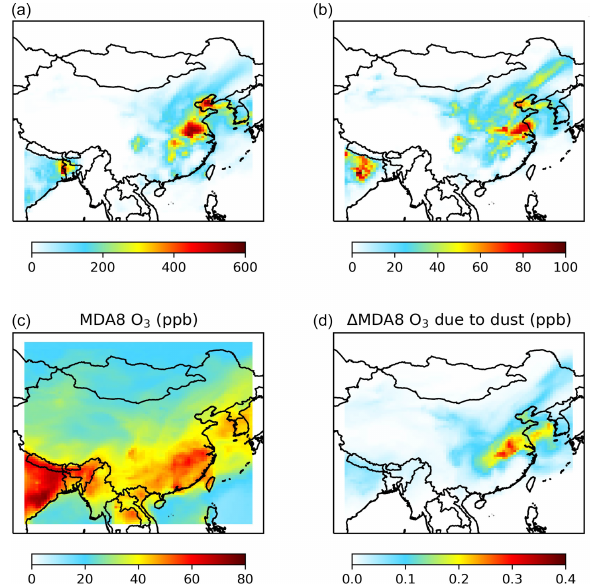
Figure 8. Modeled weekly mean mixing ratios of nighttime maxi- mum ClNO 2 (a, b) and maximum daily 8h average (MDA8) ozone (c, d) in surface air over China during 2–7 May 2017. The left panels (a, c) show simulated mixing ratios in our standard case in which ϕ (ClNO 2 ) is assumed to be 0 for N 2 O 5 uptake onto dust aerosol. The right panels (b, d) show impacts of ClNO 2 formation due to N 2 O 5 uptake onto dust, calculated as the difference between the standard case and the case in which ϕ (ClNO 2 ) is assumed to be 0.1 for N 2 O 5 uptake onto